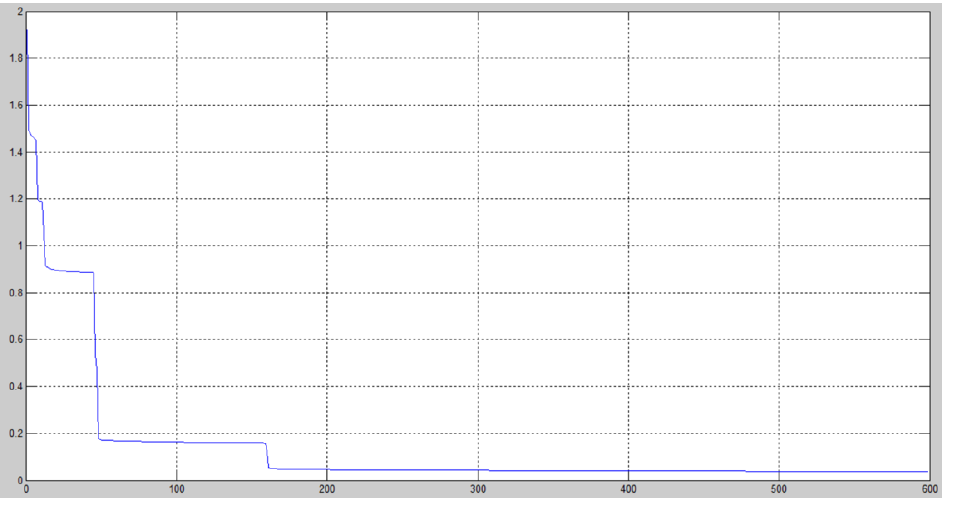
Figure 8. Error change during the training.